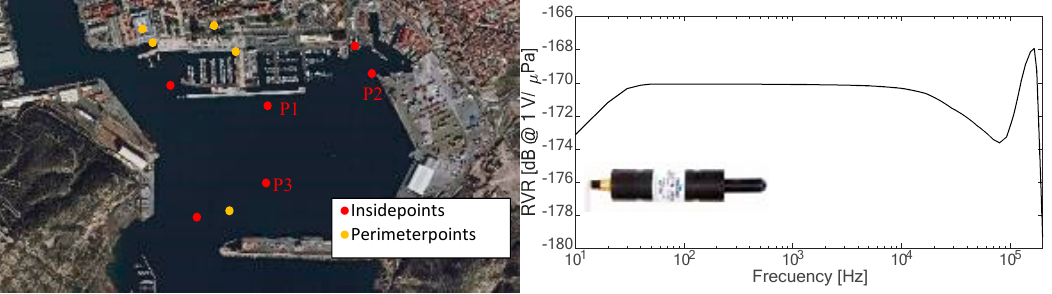
Figure 4. ( left ) Location of all the measurements points. ( right ) Received voltage response (RVR) of the hydrophone used.